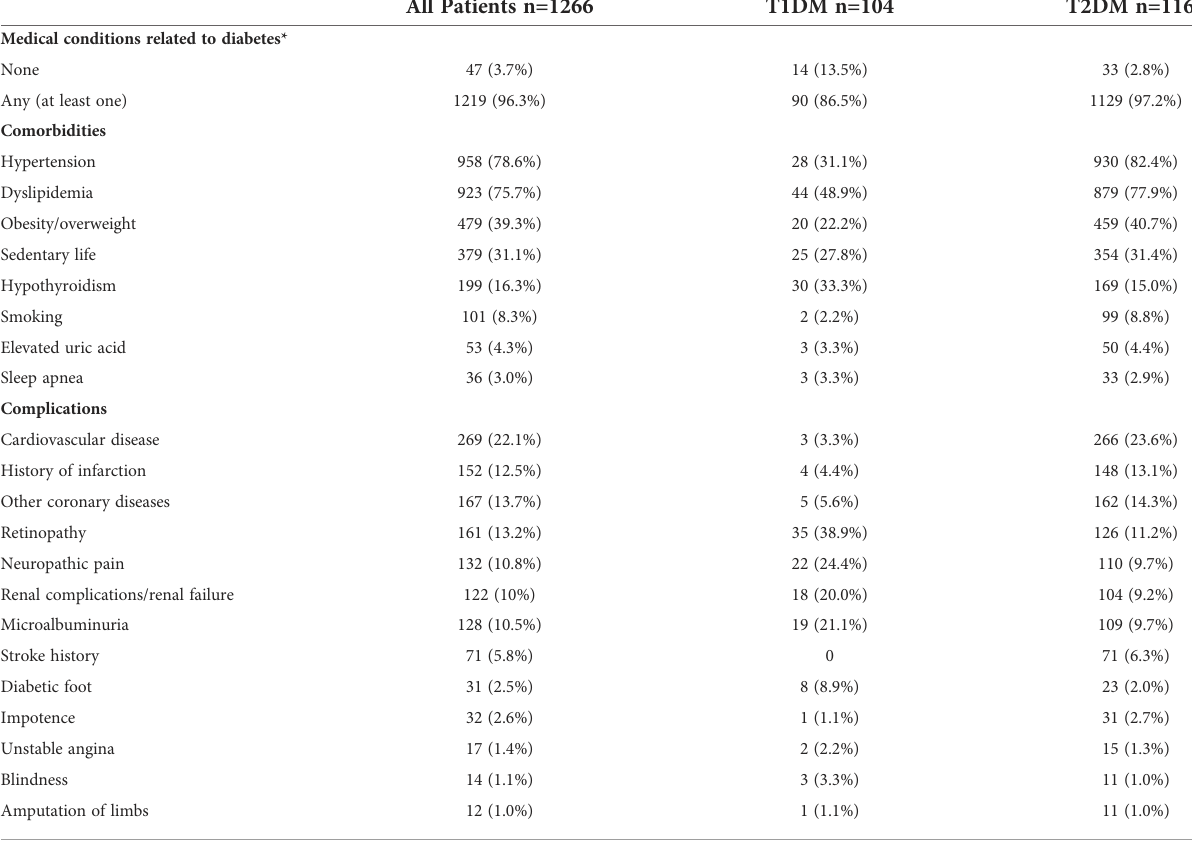
TABLE 2 Comorbidities and complications related to diabetes during the study